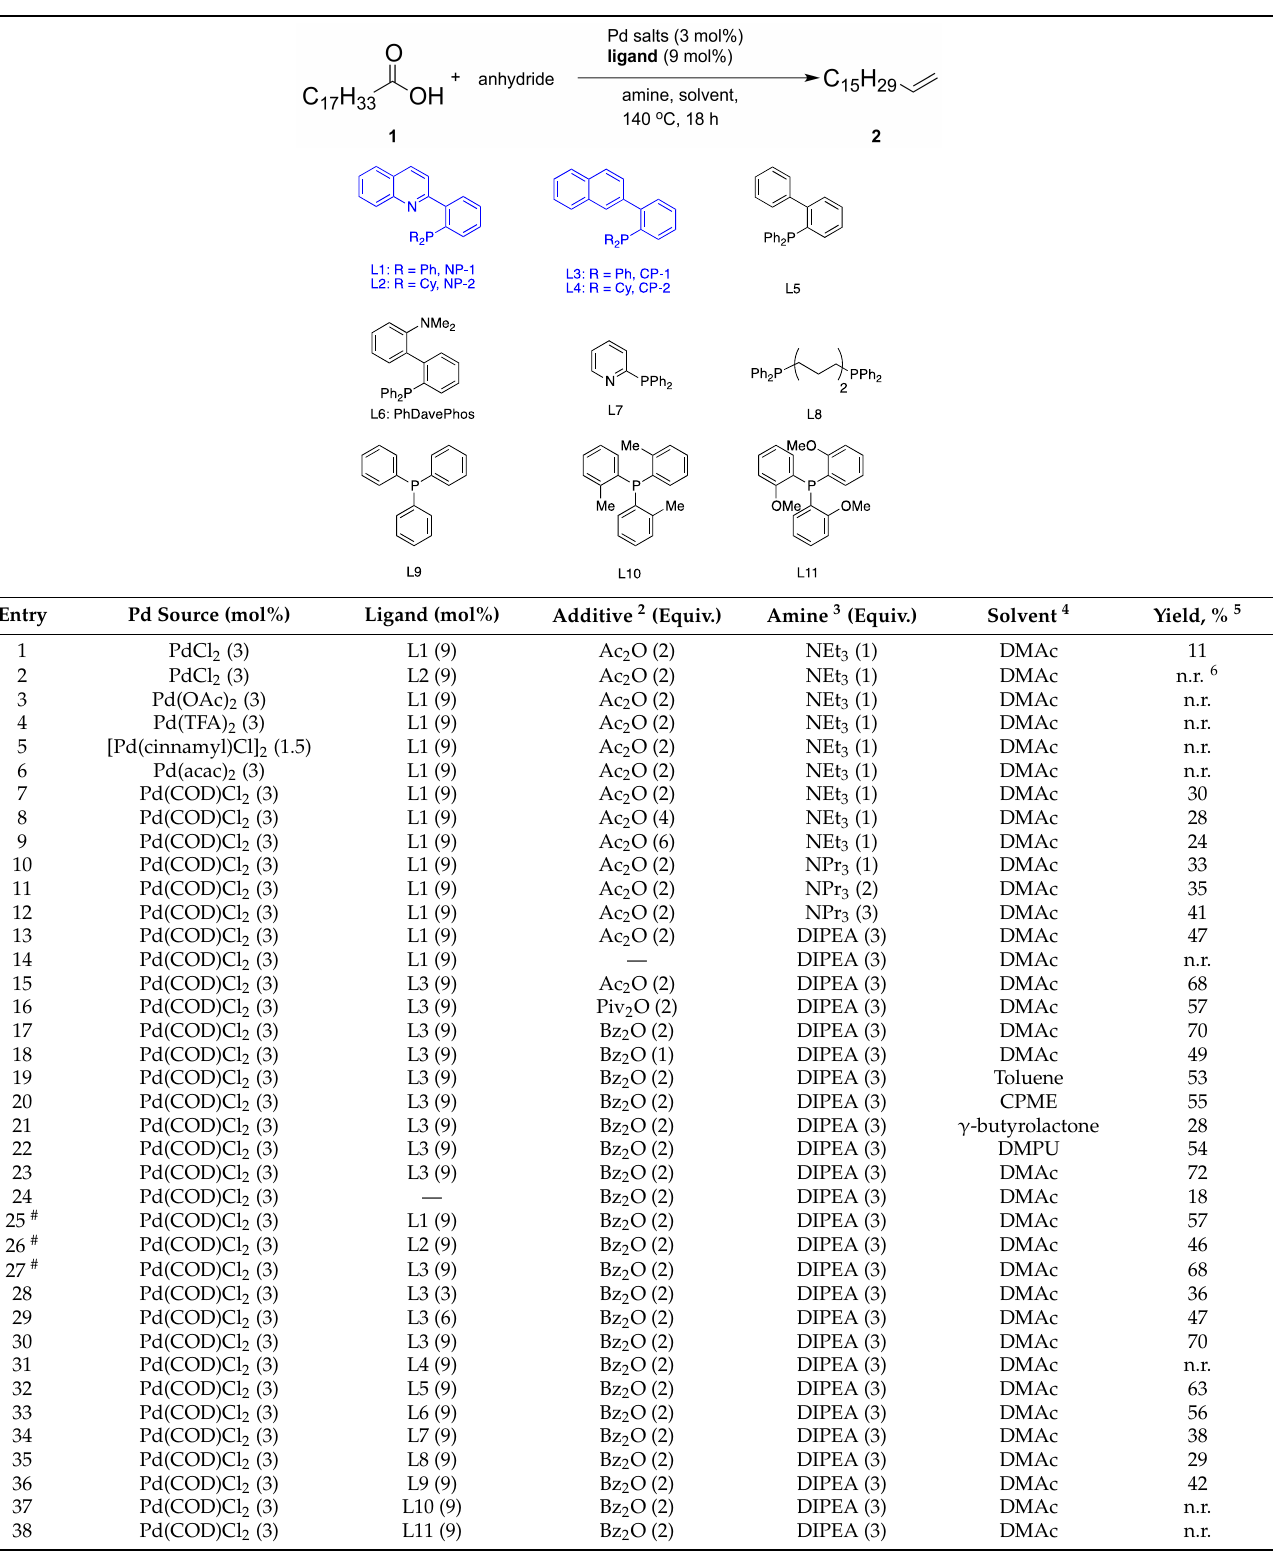
Table 1. Optimization of the Pd-catalyzed decarbonylation of carboxylic acids. 1